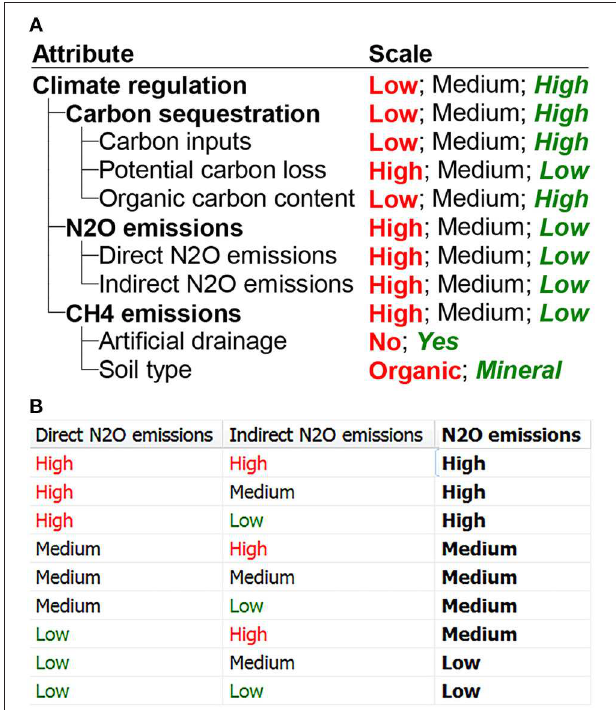
FIGURE 2 | Top part of the DEX model for the climate regulation and carbon sequestration soil function. (A) Hierarchical structure and scale values of attributes. (B) Integration rules for integration of direct and indirect N 2 O emissions into N 2 O